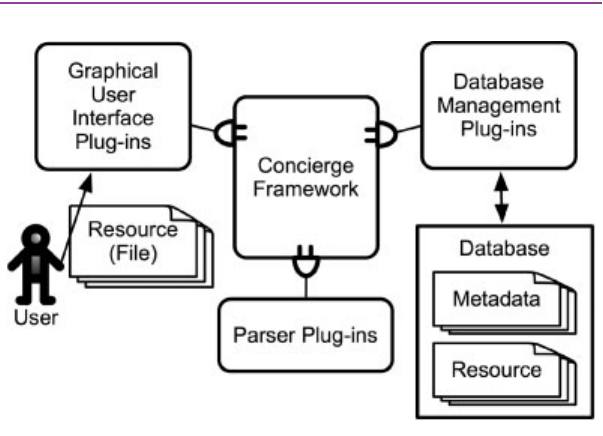
Figure 3. Concierge system architecture . The framework is the Eclipse Rich Client Platform. All building blocks of the software are, therefore, implemented as plug-ins. User requests are accepted by various GUI plug-ins and are pro- cessed by MP and DBM plug-ins. All resources are stored in the database along with their metadata.